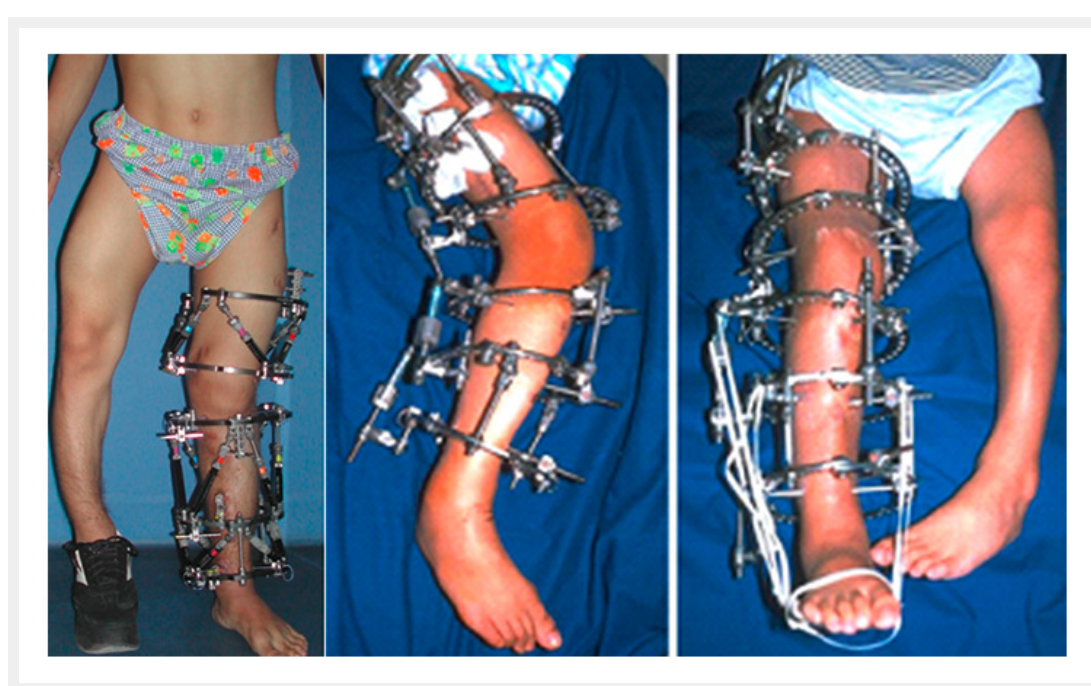
Figure 2 After proximal and distal femoral osteotomy, or a proximal tibial osteotomy of the lower limbs (in different patients), a Taylor spatial frame was